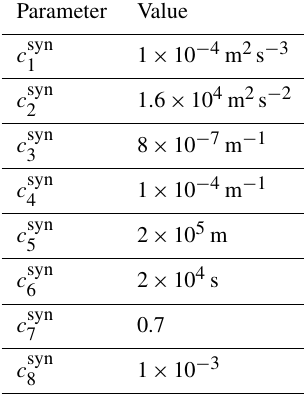
Table A4. Parameters for synoptic